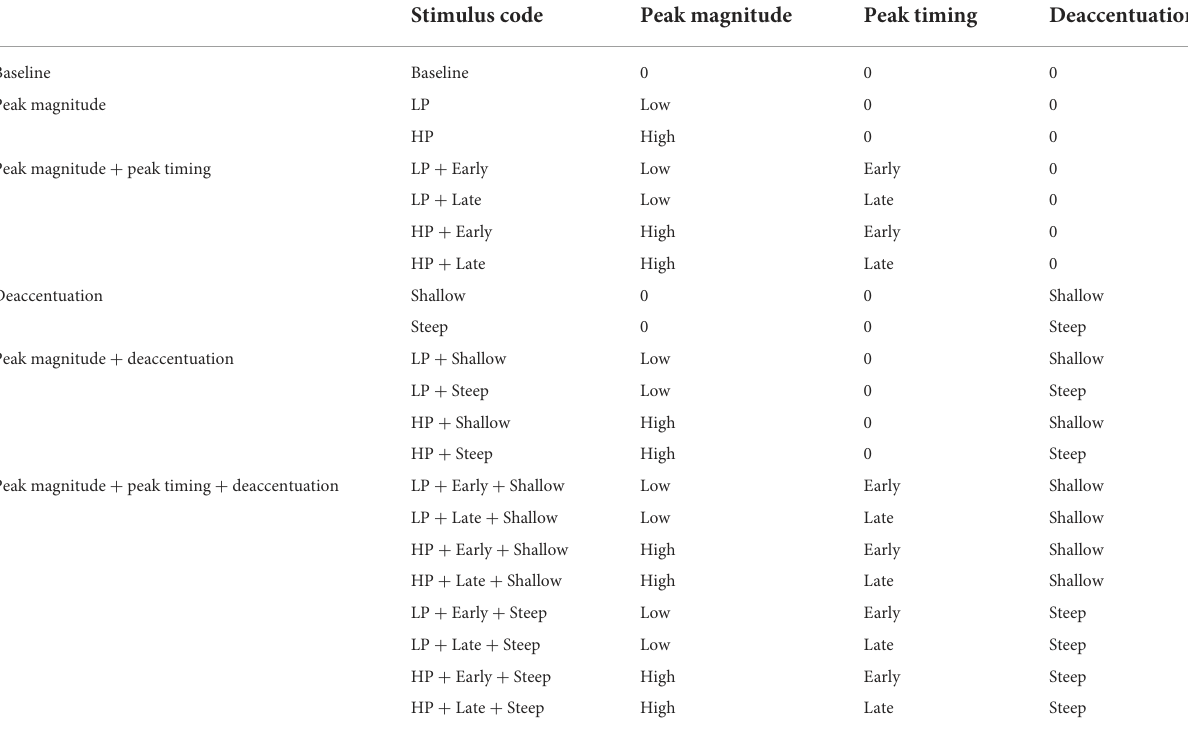
TABLE 1 Types of manipulation and their combinations in synthetic stimuli. Stimulus code Peak magnitude Peak timing